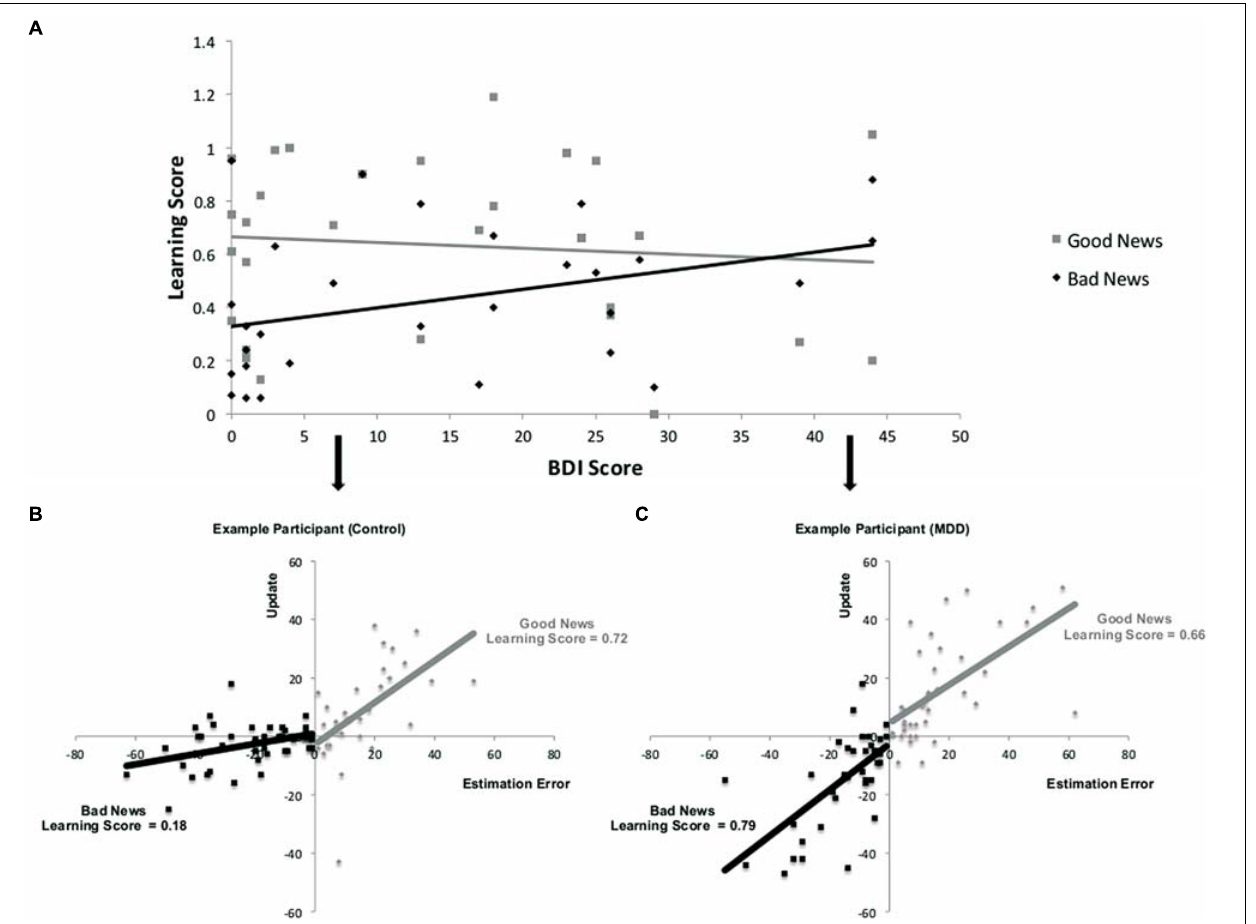
received bad news.The slope of each line is the learning score of that participant. In this example, learning from bad news is worse than learning from good news in the healthy participant (B) but does not differ as much for the depressed participant (C) . Note that for display purposes we have reversed the sign of update and estimation errors for bad news trials so that the plots do not sit on top of each